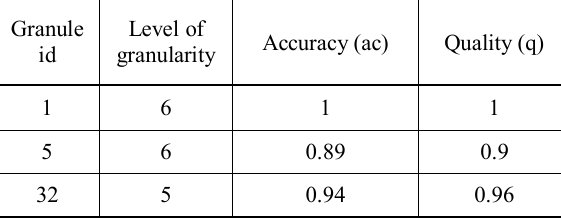
Table 2. Quality measurements of granules showing level of the granule in the hierarchical structure, accuracy and quality values GrC applied to the selected granules and 30 classification rules were extracted. Quality measures for some of these rules are shown in Table 3, whereas Figure 4 shows the obtained decision tree.